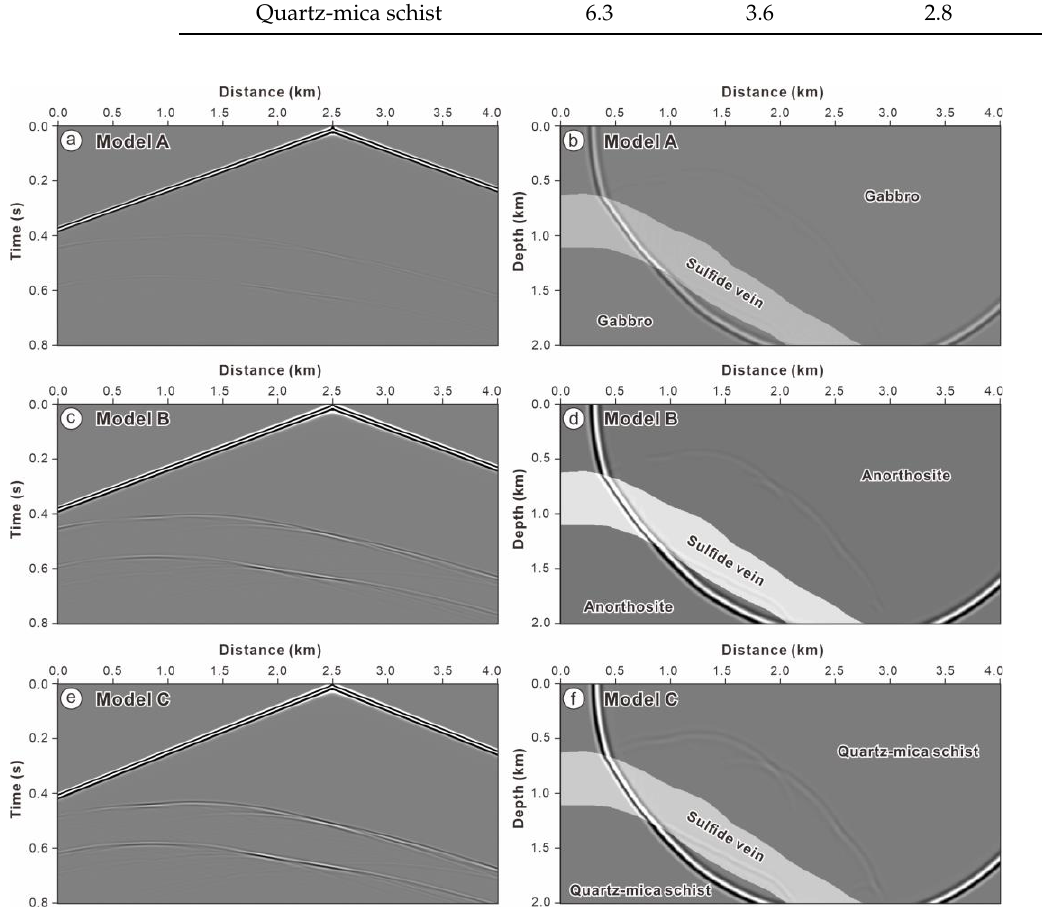
Figure 1. Synthetic seismograms ( a , c , e ) and snapshots ( b , d , f ) at 0.328 s of the compressional wave- fields in models A – C. The exploration target was defined as a sulfide vein. Gabbro, anorthosite, and quartz-mica schist were used as host rocks in models A – C. See rock properties in Table 1.